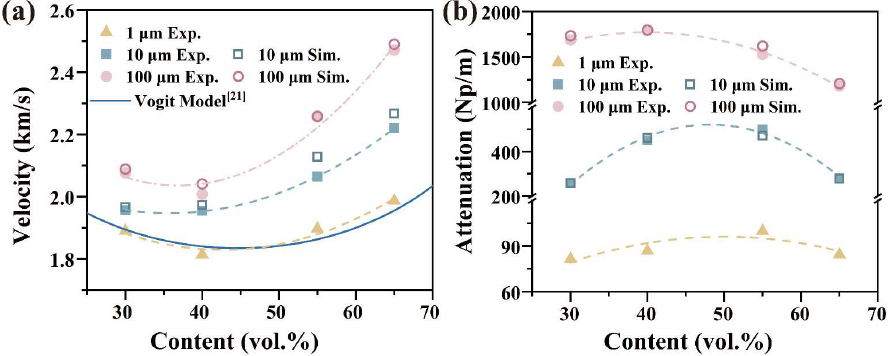
Figure 4. Elastic wave Propagation Behavior of Cu/PMMA composites: ( a ) Elastic wave velocity; ( b ) Elastic wave a(cid:308)enuation.